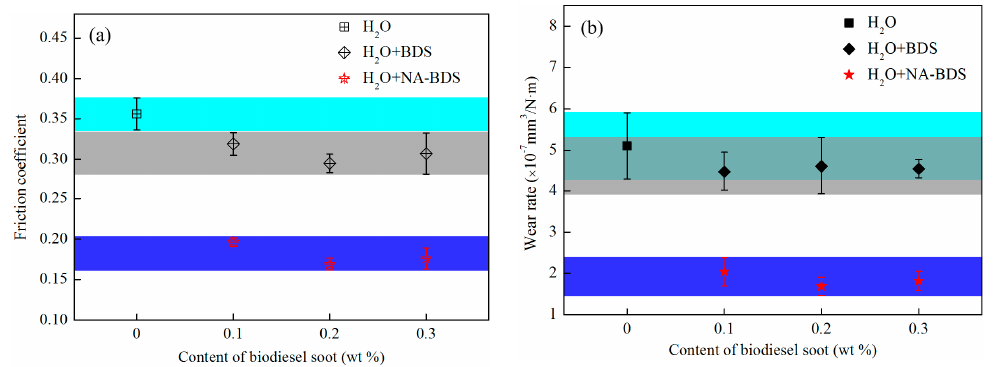
Figure 6. Evolutions of the ( a ) average friction coefficient and ( b ) wear rates for lubrication with different amounts of BDS and NA-BDS in H 2 O (load = 50 N, speed = 50 mm/s, duration = 30 min).